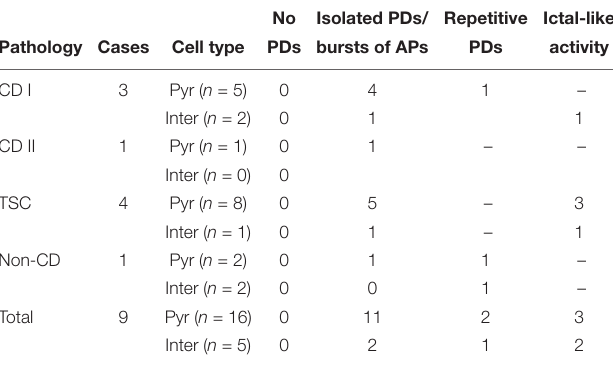
TABLE 3 | Effects of 4-AP + BIC +